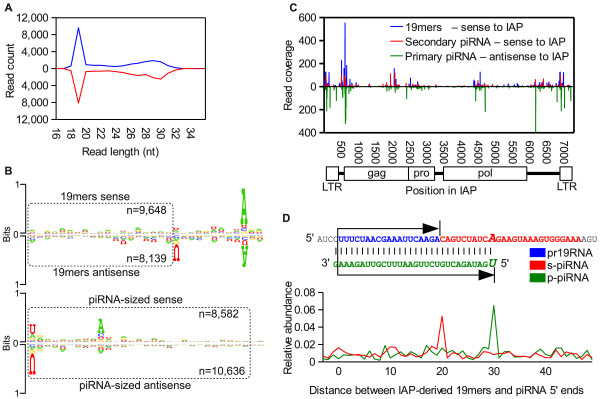
Features of small RNAs mapped to an IAP consensus sequence (A) The lengths of small RNAs that mapped to IAP are presented. Reads mapped to the sense strand are presented above the x-axis, and reads mapped in antisense below. (B) The sequence composition of the IAP-derived 19mers and piRNAs were obtained from sequence logos. The reads were separated by their orientation relative to an IAP reference sequence and plotted separately, as indicated. The sequence logos were also extended beyond the 3' ends of the reads (unboxed regions) to reveal any downstream sequence bias. (C) The density of 19mer RNAs mapped to IAP in sense (only reads with an A 10nt downstream and absence of U immediately downstream of the 3' terminus were used), secondary piRNAs mapped to IAP in sense (24-30nt RNAs with A in position 10 and absence of 5' U) and primary-piRNAs mapped to IAP in antisense (24-30nt RNA with 5' terminal U and absence of A in position 10), are plotted. Only the 5' ends of the reads were used to calculate the density. (D) The abundances of IAP-derived p-piRNAs and s-piRNAs, at varying distances from IAP-derived piRNA-related 19mers (pr19RNAs) 5' ends, were tallied and are presented as proportions of the total RNA count.